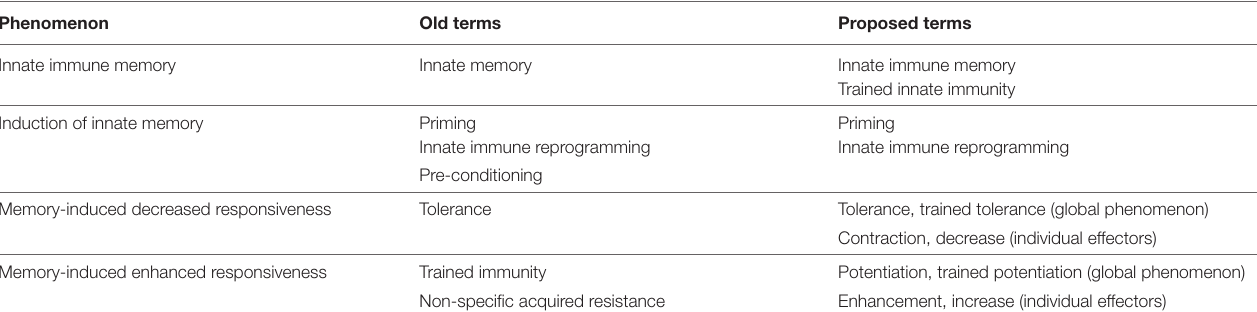
TAblE 1 | Innate immune memory